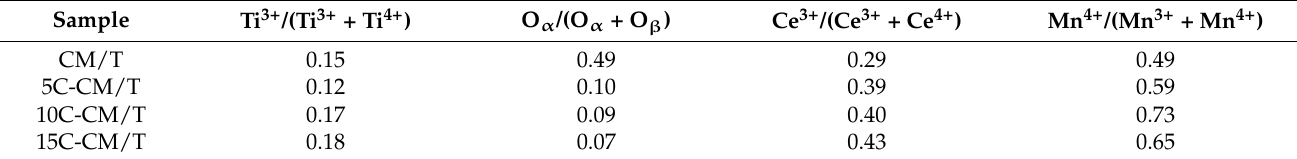
Table 2. Atomic ratios of Ti, O, Ce, and Mn in obtained